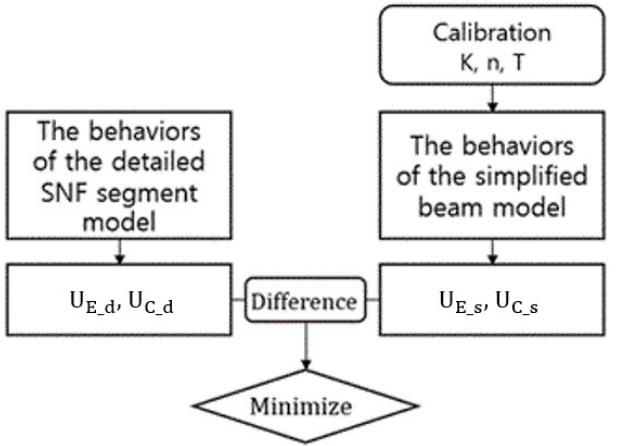
Figure 9. Optimization formulation of the simplified beam model. The structural response of the simplified beam model was calculated using the ABAQUS/Standard (V2016, Dassault Syst è mes Simulia Corp, Warwick, RI, USA). Us- ing MATLAB (R2016, Mathworks, Natick, MA, USA), the stress–strain relationship model is created by inputting the Zircaloy-4 property equation and calibration parameters K , n , and T . The material properties model is then inputted into the ABAQUS material table, and the displacement of the simplified model required for calculating the optimization objective functions is calculated. The displacement output is the input to the ISIGTH, and the design variables are updated until the objective function is minimized through the adaptive simulated annealing (ASA) method [26]. A total of 2,784 iterations for the fully bonded condition and 242 iterations for the fully de-bonded condition were performed before optimal solutions were obtained. The optimization results corresponding to each PCI condition are shown in Table 4. The material model derived through the optimized design variables was applied to the simplified model, and the deformed shape of the detailed model and the simplified model are compared in Figure 10. Figure 11 shows the moment–displacement curve. It is shown that the deflection of the simplified models agrees well with those of the detailed models at the evaluation points ( U E , U C ), although a slight discrepancy is observed in the plastic region. In the comparison of the membrane plus bending stress of the von Mises stress in the simplified model, which is the fuel rod failure criterion of the detailed model proposed in this study, it has a deviation of 44% in the fully bonded condition and 67% in the fully de-bonded condition. An idealized Euler beam cannot express the localized stress concentration observed in actual fuel rods, and this discrepancy in the stress was predictable. In this study, the error ratio was used